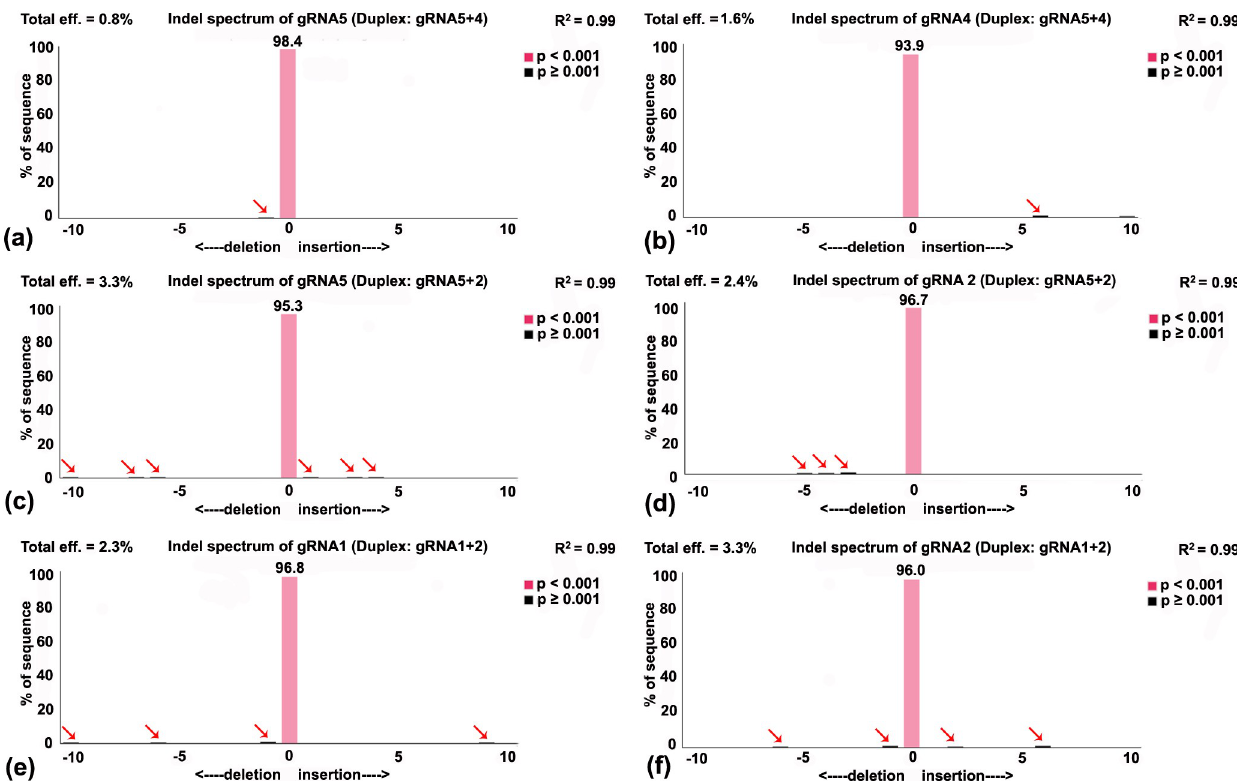
Fig 6. Indel spectrum analysis through TIDE programme. Analyses showed probability of presence of NHEJ generated mutated sequences in upstream or downstream to the PAM motifs in ChiLCV genome after treating with three promising duplex gRNA-Cas9 constructs. Three replicates of the viral genomic sequences from individual plant were identical and hence analysis was done with one sample. Indel spectra generated surrounding the cleavage site of (a) gRNA5 (duplex: gRNA5+4), (b) gRNA4 (duplex: gRNA5+4), (c) gRNA5 (duplex: gRNA5+2), (d) gRNA2 (duplex: gRNA5+2), (e) gRNA1 (duplex: gRNA1 +2), (f) gRNA2 (duplex: gRNA1+2). The analysis showed in all combinations no significant escape mutants were present. Arrow indicated insignificant occurrence of mutated sequences surrounding the PAM motif of each gRNA targeting region of